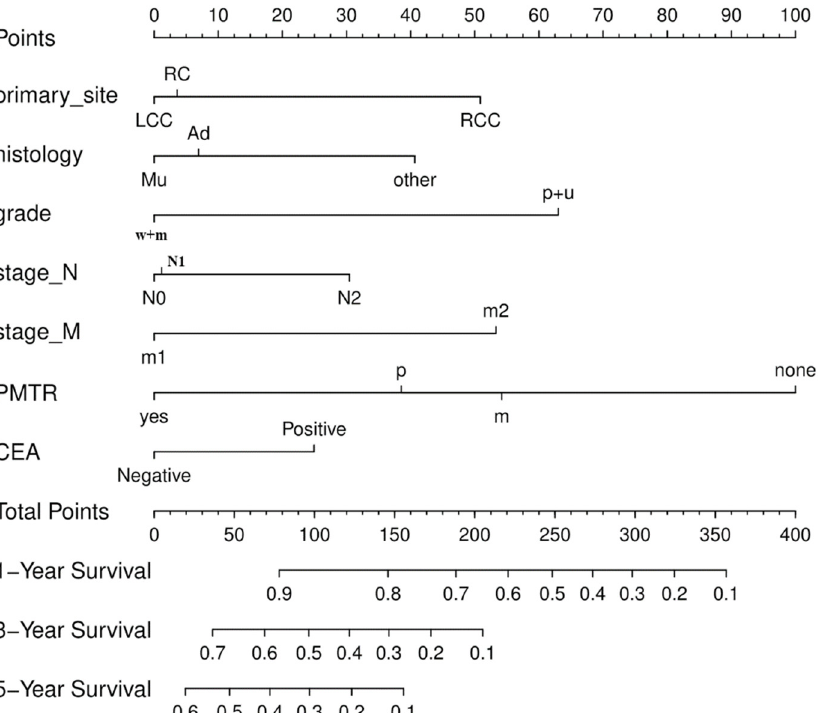
Figure 2. The Nomogram for predicting cancer-specific survival (CSS). Right colon cancer (RCC); Left colon cancer (LCC); Rectal cancer (RC); Well + Moderately (w + m); Poorly + Undifferentiated (p + u); Surgery (PTMR); Neither (none); Primary+ Metastatic (yes); Only primary (p); Only metastatic (m).